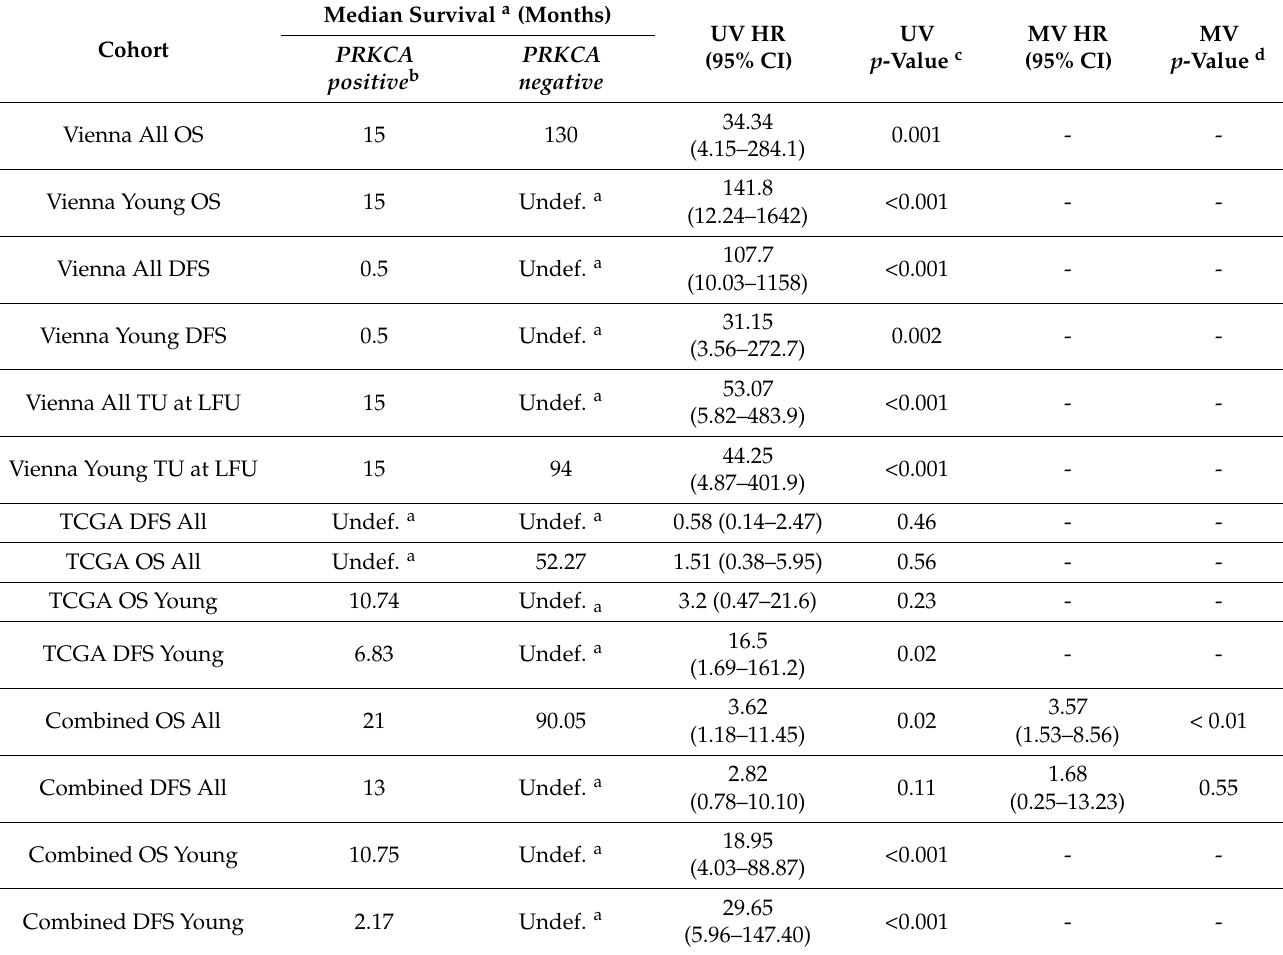
Table 3. Median overall and disease-free survival times and hazard ratios in the patient subgroups as a function of PRKCA overexpression.Abbreviations: PRKCA, protein kinase C alpha; UV, univariate; MV, multivariate; HR, hazard ratio; CI, confidence interval; OS, overall survival; DFS, disease-free survival; TU, tumor; LFU, last follow-up; undef.,